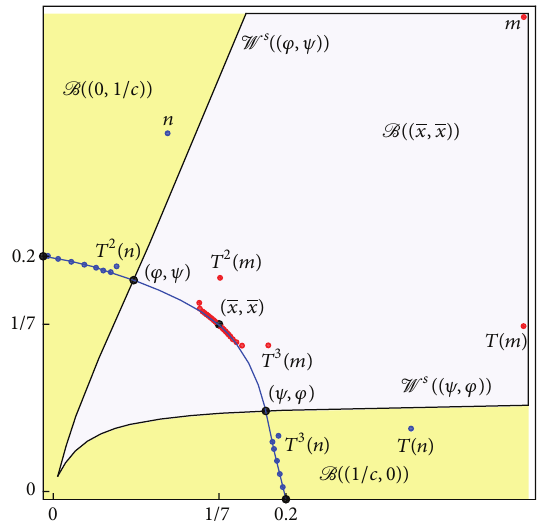
Figure 2: Global dynamics of (1) for 𝑎 = 2 , 𝑏 = 2 , and 𝑐 = 1 —an illustration of Theorem